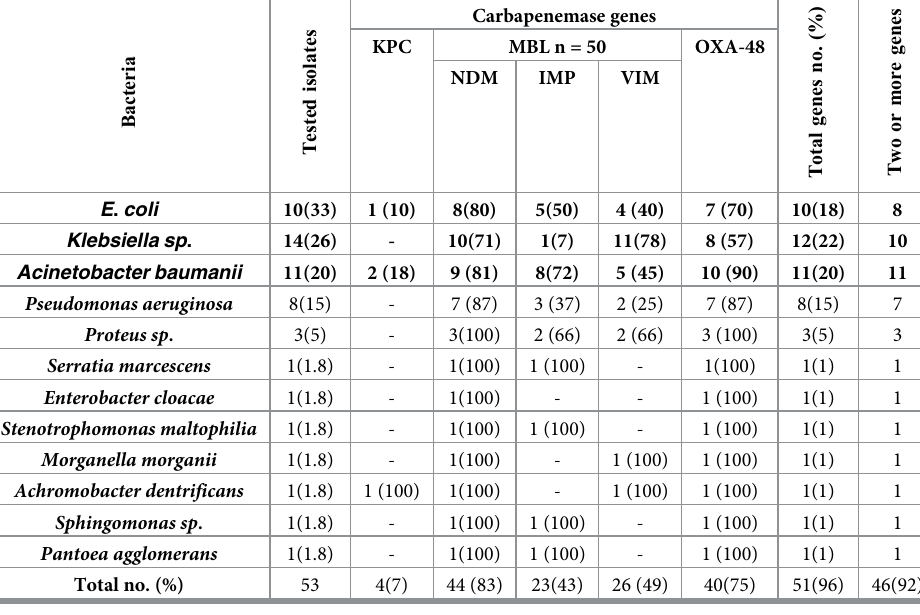
Table 5. Genotype detection of carbapenemase-producing Gram-negative